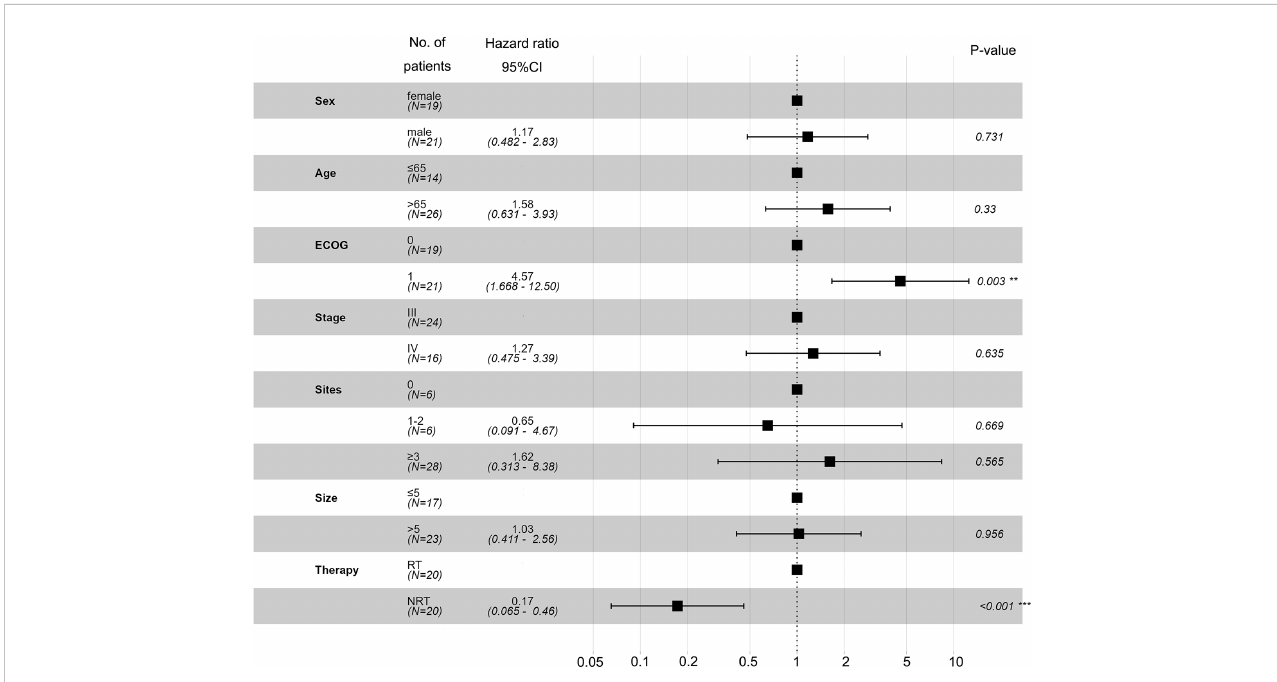
FIGURE 3 Univariate and multivariate analyses based on the Cox regression model were performed to identify independent prognostic factors associated with